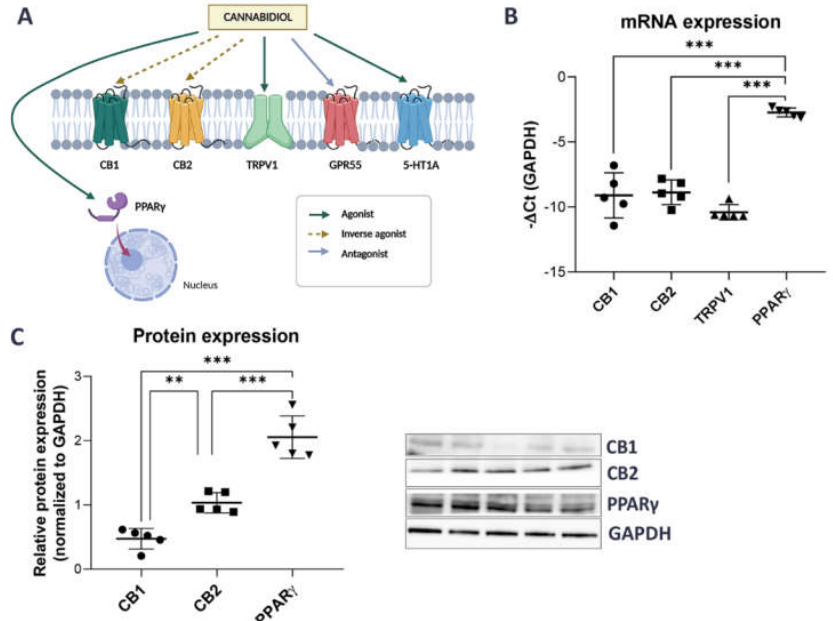
Figure 1. mRNA and protein expression of CBD-related receptors in SV-HUC1 cells. ( A ) CBD can mediate its effect through several receptors, including CB1, CB2, TRPV1, GPR55, 5-HT1A and nuclear receptor PPARγ [45,47]. The figure was created using Biorender.com ( B ) mRNA expression of CB1, CB2, TRPV1 and PPARγ in SV-HUC1 cells as determined by qPCR. Shown is mean ± SD negative ∆ Ct of four replicates normalized to GAPDH. ( C ) Protein expression of CB1, CB2 and PPARγ receptors in SV-HUC1 cells as determined by western blots. Shown is mean relative expression ± SD of five replicates normalized to GAPDH. Representative blots for each receptor are shown. ** p < 0.01; *** p < 0.001.